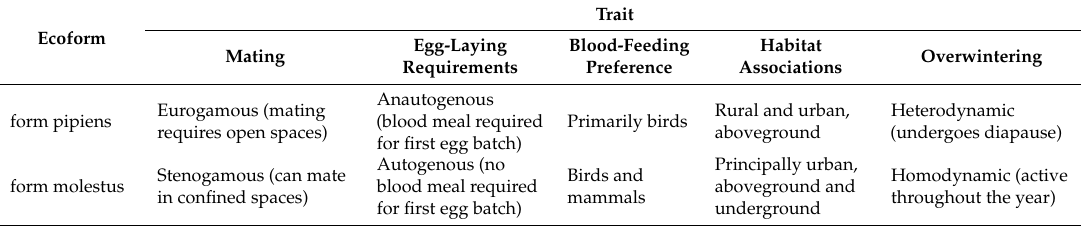
Table 2. Comparative summary of the behavioural and physiological traits of Culex pipiens ecoforms. Ecoform